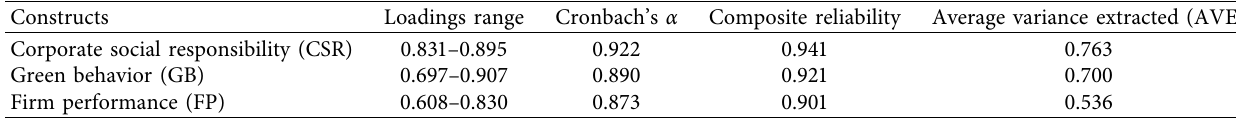
Figure 1: SmartPLS algorithm graph. Table 1: Construct reliability and validity.